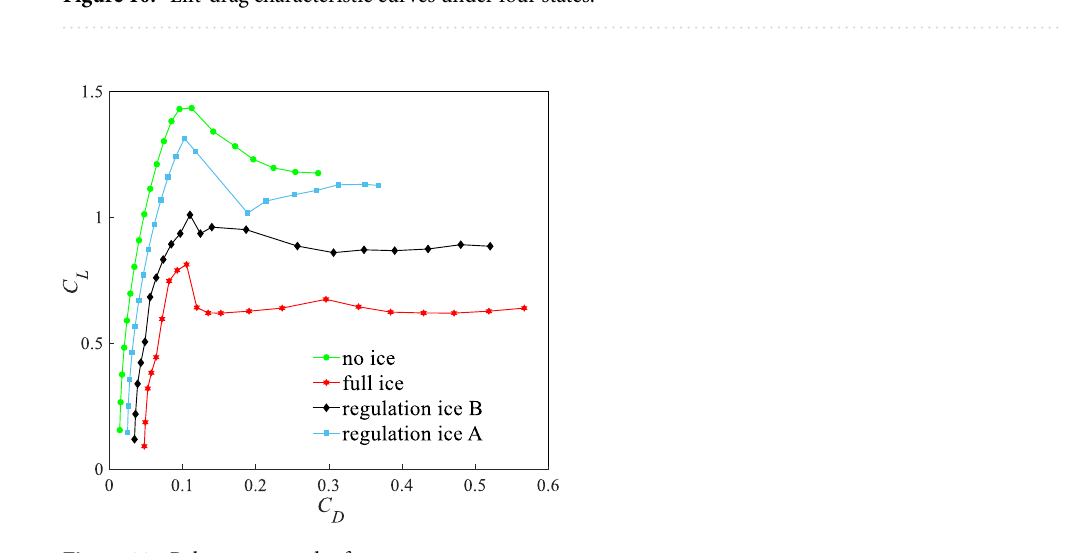
Figure 11. Polar curves under four